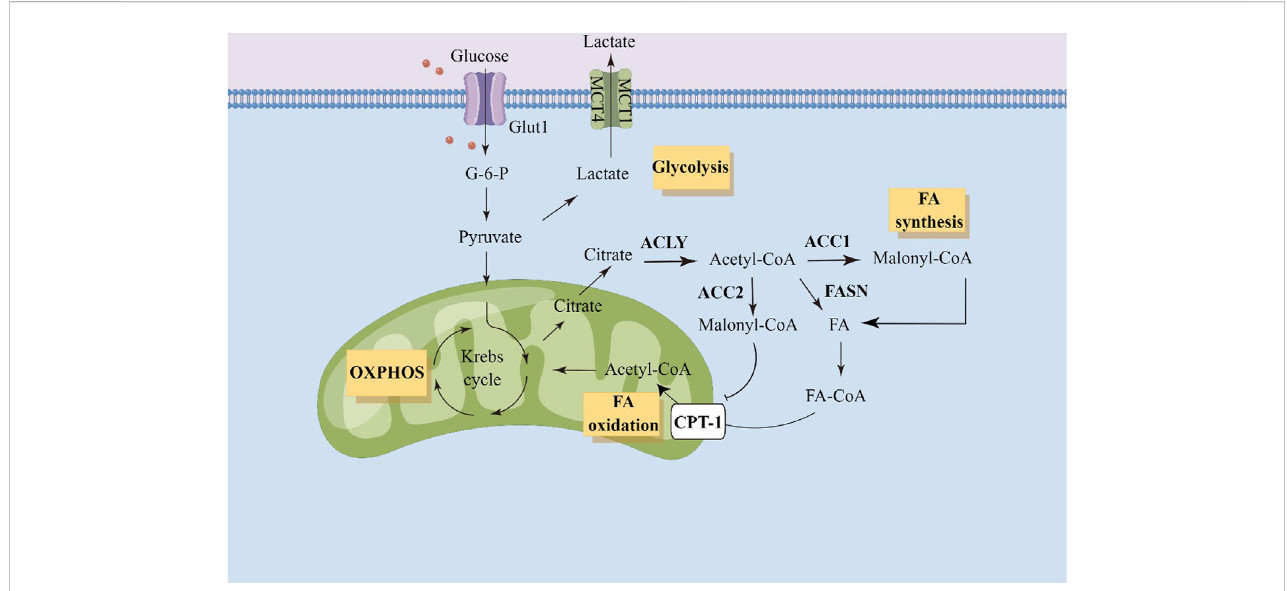
FIGURE 1 Illustrationoffattyacidmetabolismintumorcells.ACC,acetyl-CoA carboxylase;ACLY,ATPcitratelyase;Glut1,gluosetransporter1;G-6-P,Glucose-6- phosphate; OXPHOS, oxidative phosphorylation; FA, fatty acid; CPT-1, carnitine palmitoyltransferase